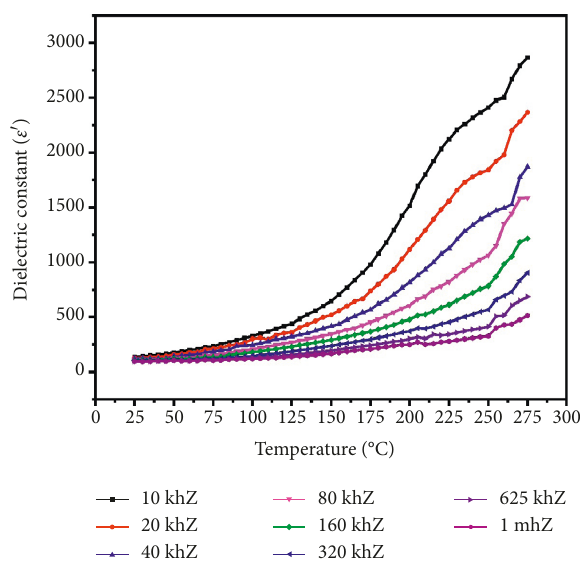
Figure 9: Dielectric spectrum of the methyl orange dye-doped K 2 SO 4 single crystal.